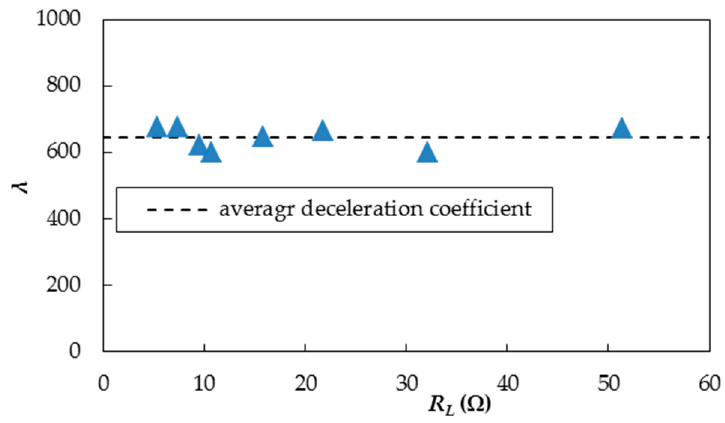
Figure 6. Deceleration coefficient λ versus load resistance R L .